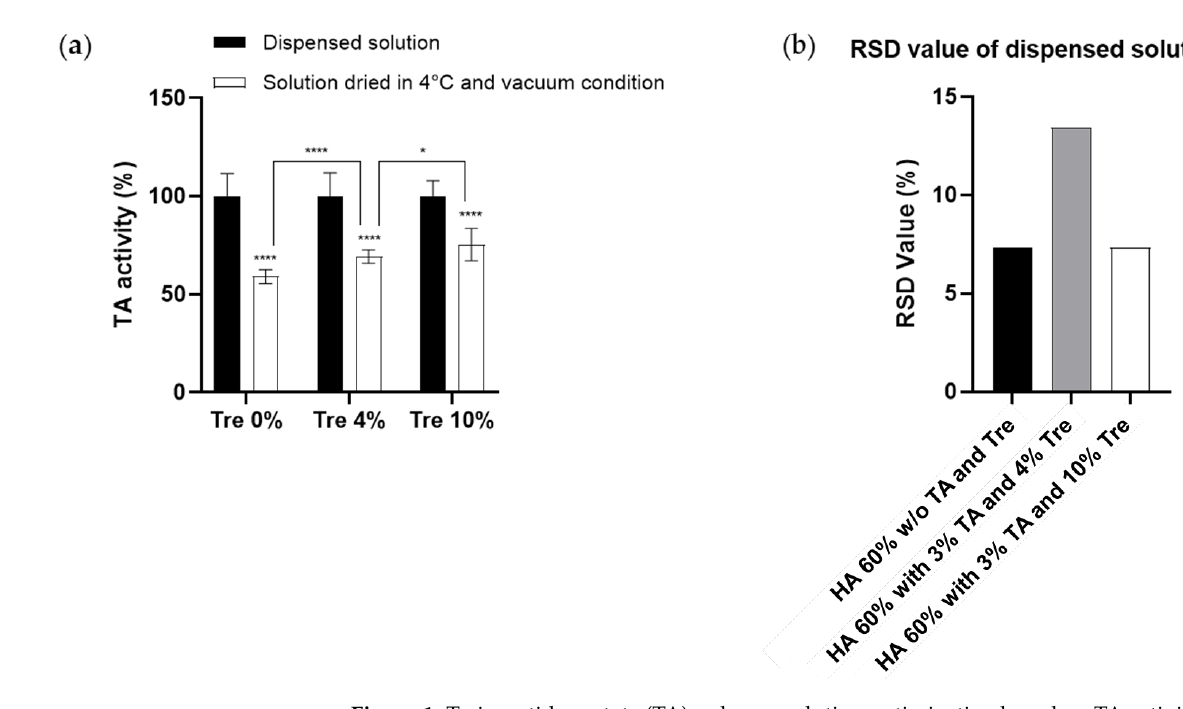
Figure 1. Teriparatide acetate (TA) polymer solution optimization based on TA activity maintenance during the drying process and solution homogeneity. ( a ) TA activity maintenance in TA polymer solution droplets dried at the CL-mimic conditions evaluated by HPLC analysis. Statistical significance was evaluated by ANOVA test and was set to p < 0.05, and values of * p < 0.05 and **** p < 0.0001 were considered to be statistically significant. n.s. means not significant. ( b ) Homogeneity of hyaluronic acid (HA) solutions without TA and trehalose and TA polymer solution.